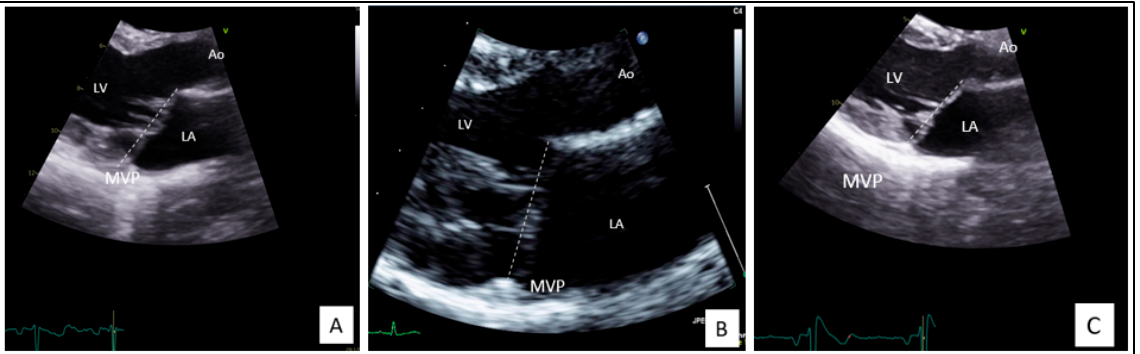
Figure 2. Echocardiography of the index case ( A ), the affected daughter (II-2) ( B ), and the oldest daughter with a prodromal MVP (II-1) ( C ). LV: left ventricle; LA: left atrium; Ao: aorta; MVP: mitral valve